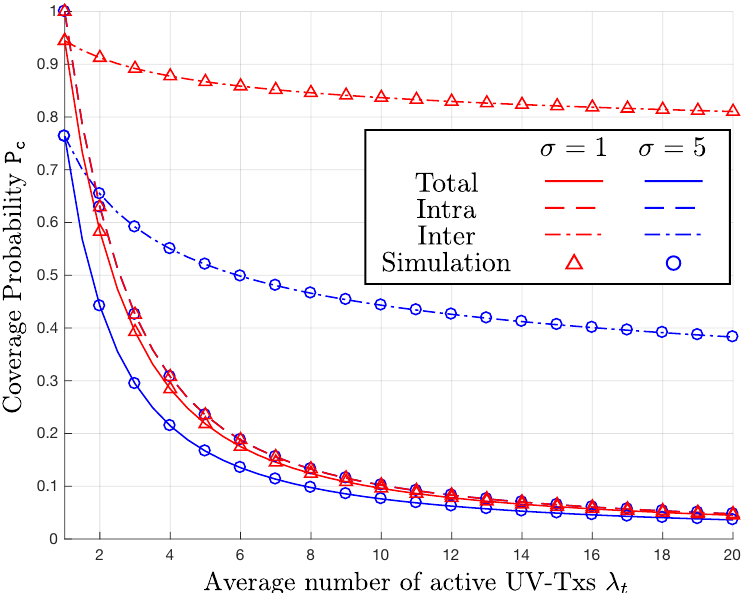
Figure 5. P c versus λ t for λ c = 30 clusters/km, σ = { 1,5 } , and β = 0